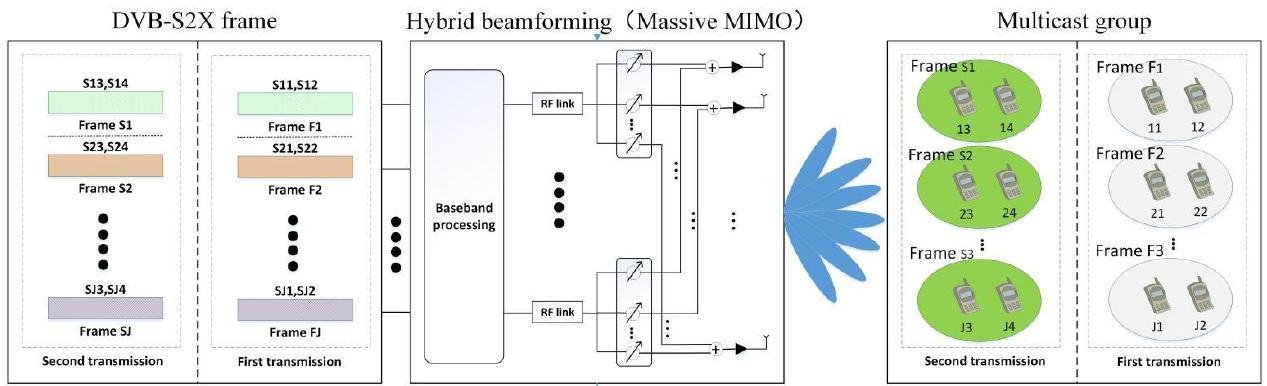
Figure 2. Service process of the LEO communication satellite multigroup multicast transmission based on the DVB-S2X.